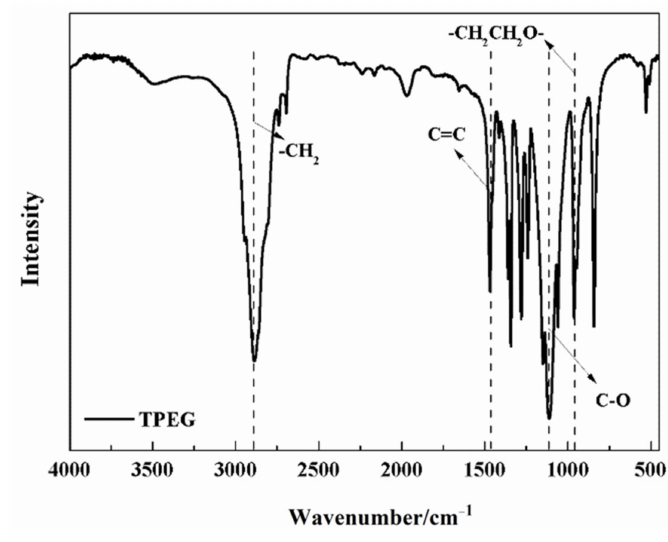
Figure 2. Fourier-transform infrared spectrum of